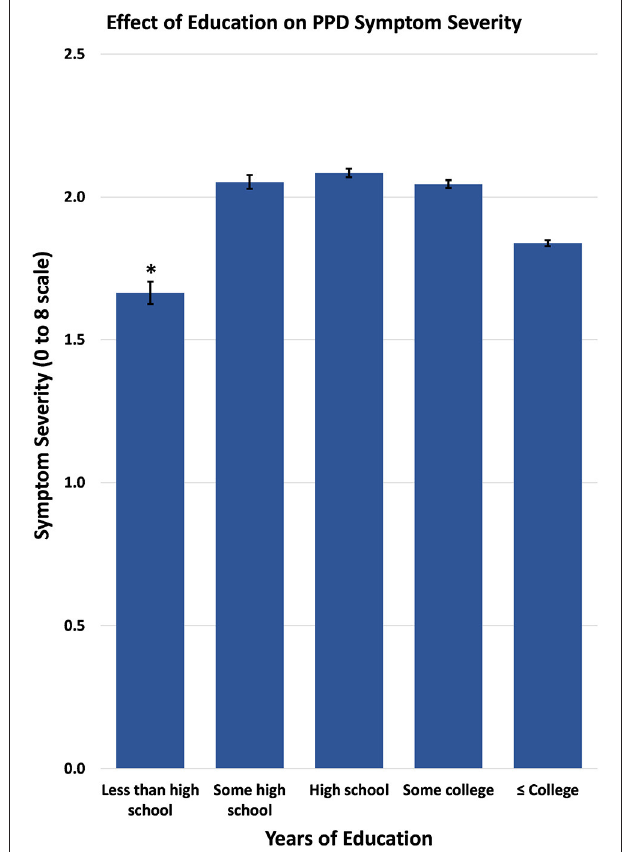
FIGURE 3 | Postpartum symptom severity by education level as reported by PRAMS